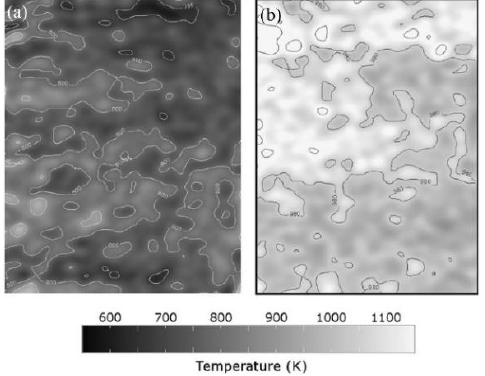
Figure 29. Single measured nozzle surface temperature field of the afterburner at the loads of ( a ) 62% and ( b ) 100% [34]. Reprinted with permission from [34]. Elsevier, 2011.